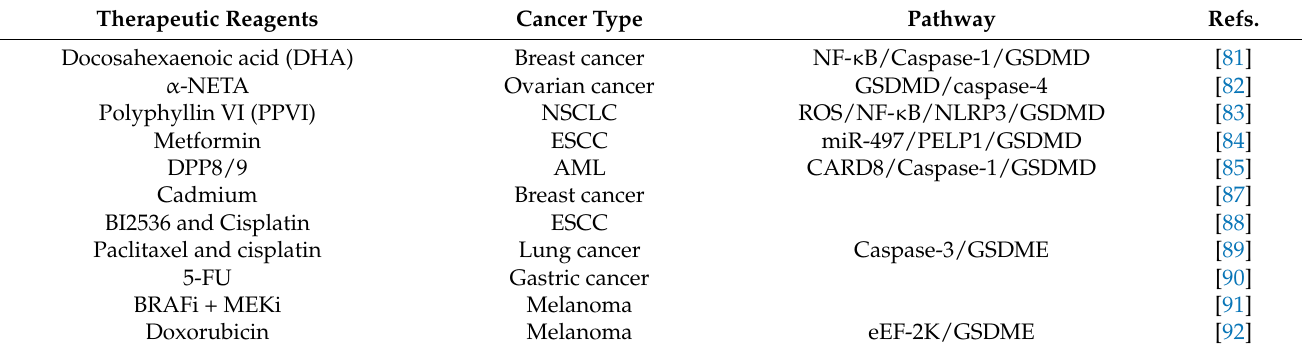
Table 2. Induction of pyroptosis in cancer by various therapeutic